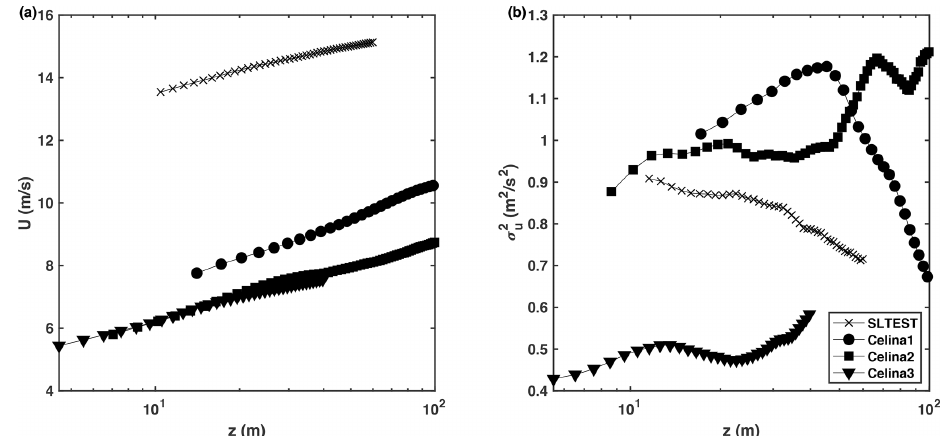
Figure 7. First- and second-order statistics of the equivalent velocity, U eq , as a function of height for the various datasets: (a) mean value and (b) variance.